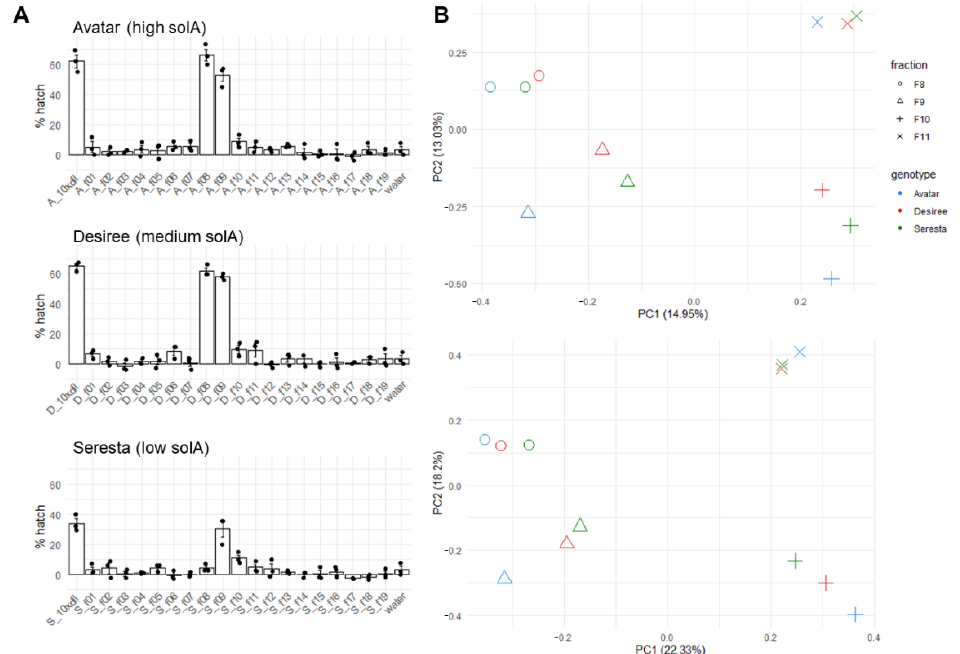
Figure 3. ( A ) Hatching of G. rostochiensis eggs under influence of fractions of three root exudates of genotypes Avatar (A), Desiree (D), and Seresta (S). These genotypes had high and low concentra- tions of solA (Figure 1A). Fractions 8, 9, 10, and 11 were selected for LC-ESI-QTOF-MS analysis. The first column shows the hatching percentage of the 10× diluted unfractionated root exudates. The concentrations of fractions are comparable to the 10× diluted unfractionated root exudates. ( B ) PCA plots of LC-ESI-QTOF-MS data positive (top) and negative (bottom) modes, of four selected frac- tions associated with high hatch-inducing activity of root exudates of the genotypes Avatar, Desiree, and Seresta. 10 × dil = 10 × diluted,. Seresta. 10 × dil = 10 ×